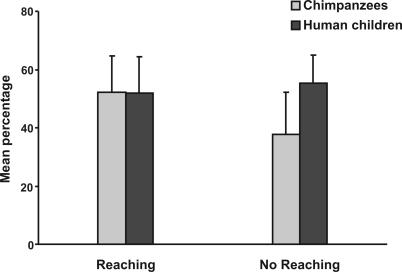
Experiment 2Mean percentage of trials with target behavior (handing the out-of-reach object to the recipient) as a function of species and condition. Error bars represent SEM. Each subject participated in one of the two conditions in a between-subject comparison.